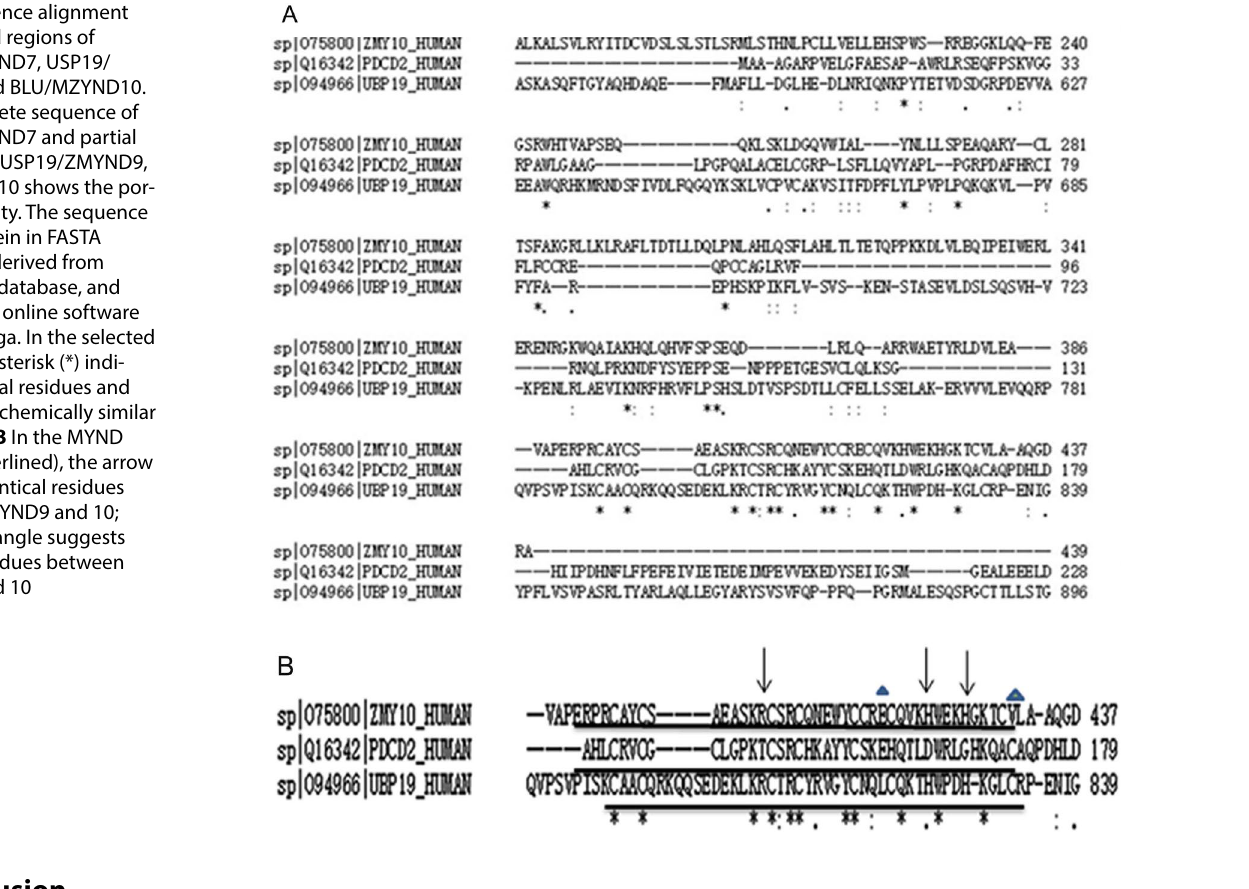
Fig. 5 Sequence alignment of conserved regions of PDCD2/ZMYND7, USP19/ ZMYND9 and BLU/MZYND10. A The complete sequence of PDCD2/ZMYND7 and partial sequence of USP19/ZMYND9, BLU/ZMYND10 shows the por- tion of identity. The sequence of each protein in FASTA format was derived from uniprot. org database, and aligned with online software Clustal Omega. In the selected region, the asterisk (*) indi- cates identical residues and the point (.), chemically similar amino acid. B In the MYND region (underlined), the arrow suggests identical residues between ZMYND9 and 10; while the triangle suggests identical residues between ZMYND7 and